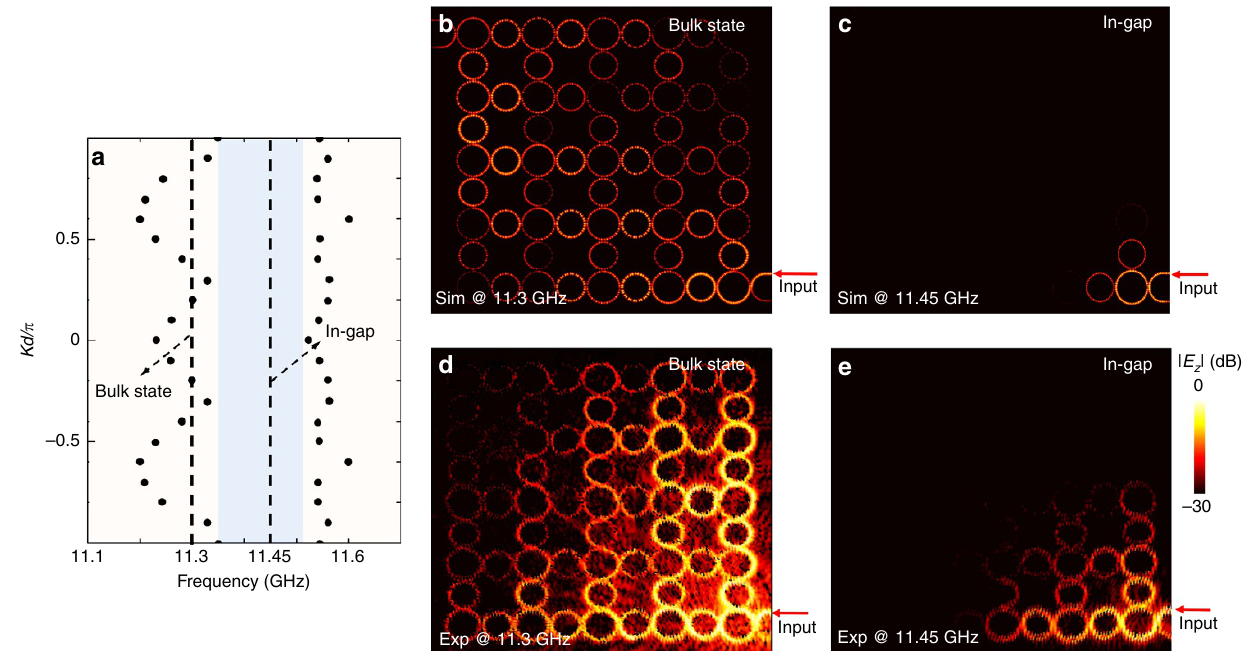
Figure 8 | Demonstration of a trivial insulator phase. ( a ) Simulated band diagram of the topologically trivial designer surface plasmon structure. ( b ) Simulated field pattern of bulk state at 11.3GHz. ( c ) Simulated field pattern at 11.45GHz in the bandgap. ( d ) Observed field pattern at 11.3GHz in the bulk band. ( e ) Observed field pattern at 11.45GHz in the topologically trivial bandgap. Metal is modelled as a perfect electric conductor in